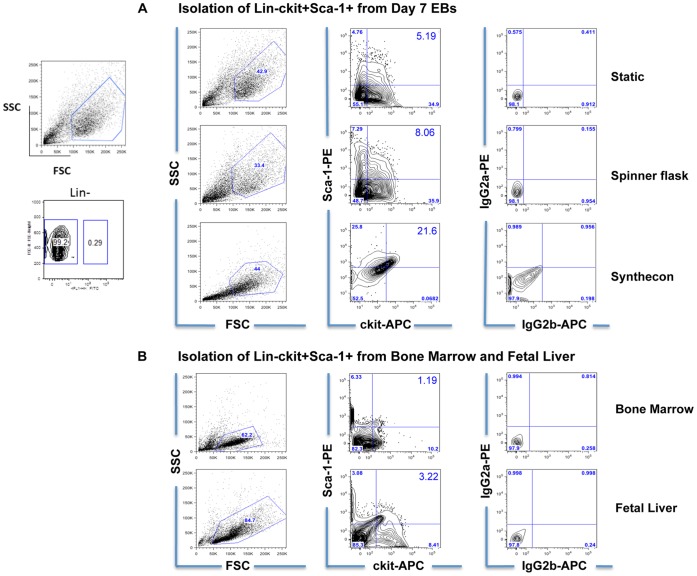
Identification and isolation of ES cells and BM- and FL-derived Lin-ckit+Sca-1+ cells.(A) Lin-ckit+Sca-1+ cells were generated from ES cells differentiated under Static and Dynamic culture conditions (Synthecon and Spinner flask) for 7 days and (B) from BM and FL. Mouse embryonic stem cells were differentiated under Static and Dynamic culture conditions (Spinner flask and Synthecon) for 7 days. Cell suspensions from day7 EBs were stained with ckit and Sca-1 antibodies to isolate the Lin-ckit+Sca-1+ population. As explained in Materials and Methods, the Lineage negative cocktail was not included for sorting because we did not observe lineage positive cells at day 7 of differentiation for any ESC culture condition (left panel). Similarly, lineage negative cells from BM and FL cell suspensions were stained with ckit and Sca-1 antibodies to isolate by cell sorting the ckit+Sca-1+ Lineage negative population (LKS). Staining with relevant isotype controls was included in each sample to determine the right ckit+Sca-1+ population.